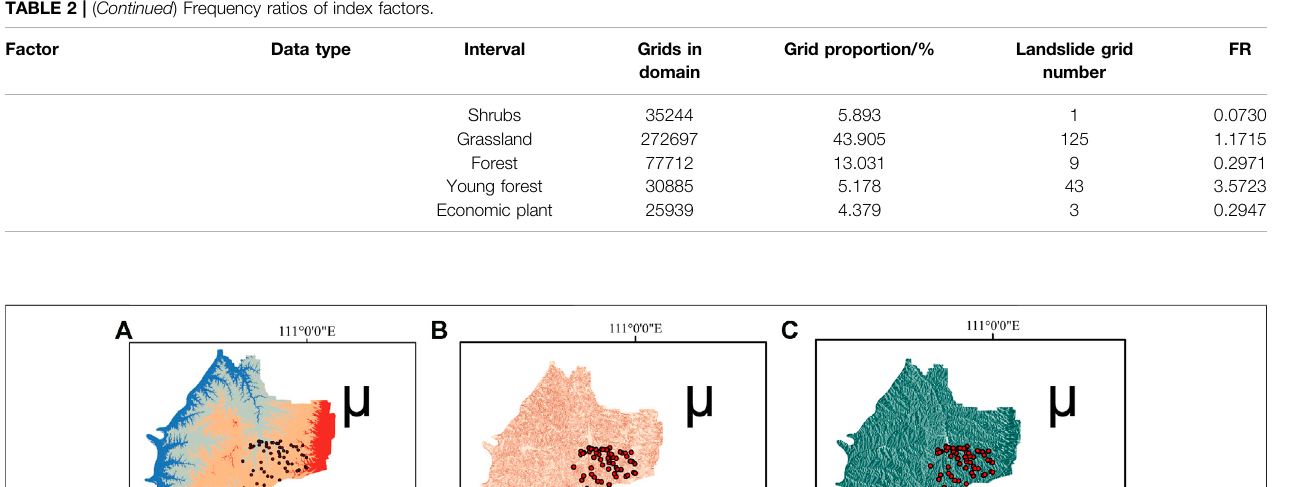
Frontiers in Earth Science |